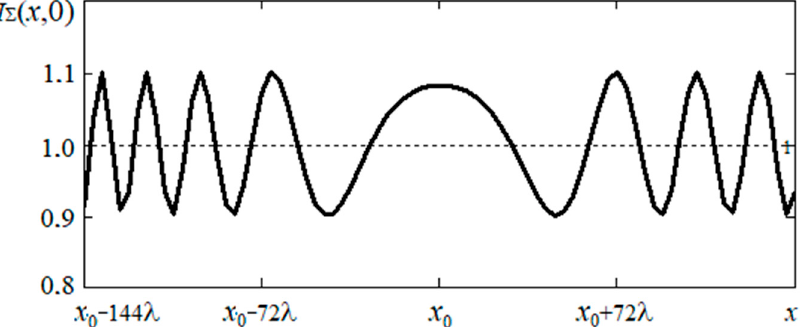
Figure 2. The radial distribution of the intensity of the optical field in the plane of the interferogram.